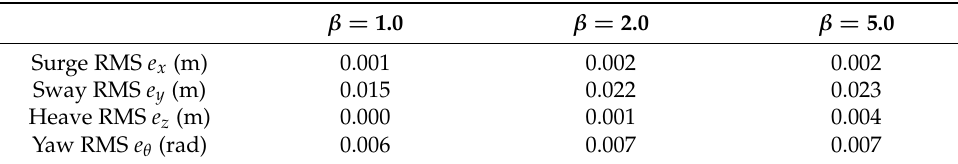
Table 2. RMS tracking errors with different